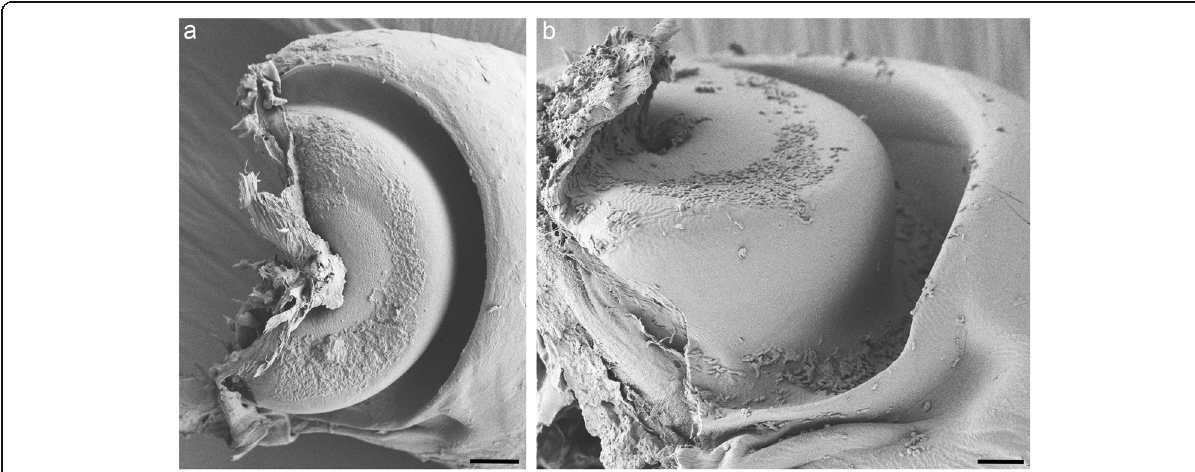
Fig. 5 Structure of the groove on the dactylus. a Scanning electron micrograph of the base of the dactylus, posterior view. A semicircular groove is visible. b The groove on the dactylus, ventral view. The surface of the groove is completely smooth. Scale bars: 10 μ m (a), 5 μ m (b)